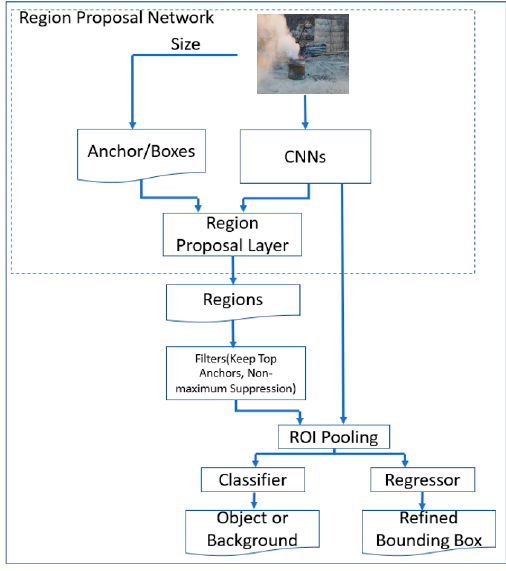
Figure 4. The architecture of faster R-CNN.